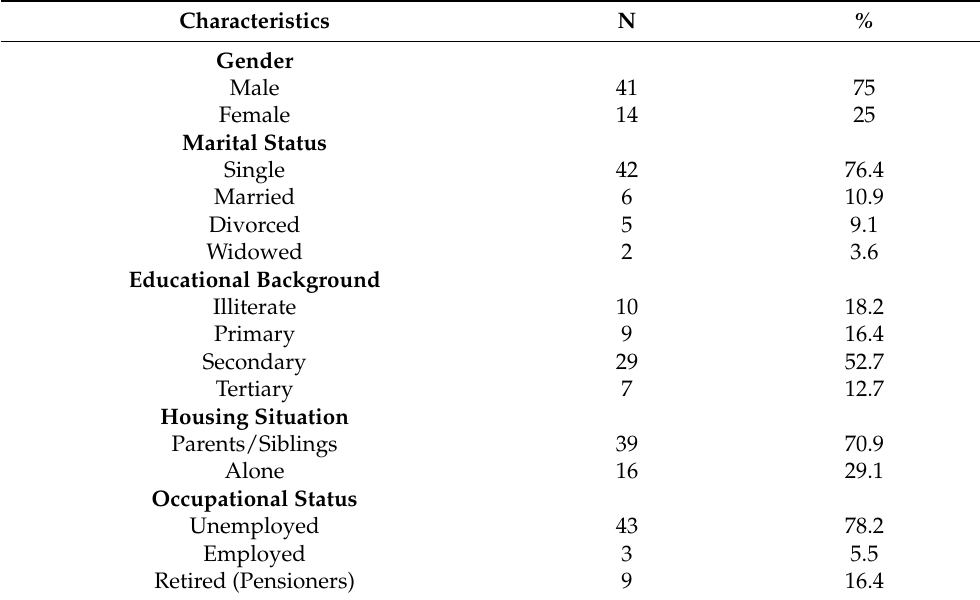
Table 1. Socio-demographic characteristics (N = 55).